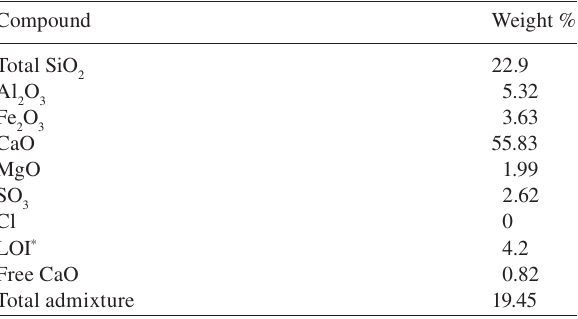
Table 4 Chemical analysis of Portland